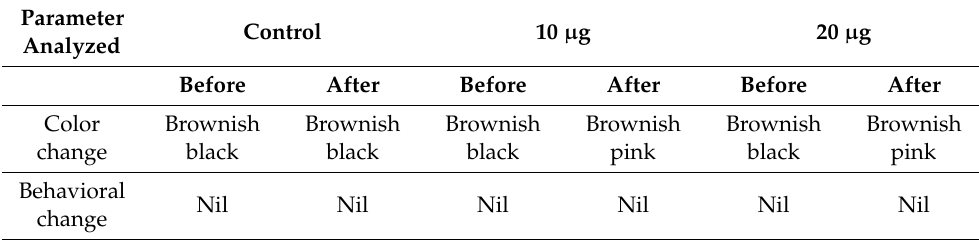
Figure 8. Phenotypic changes observed in zebrafish exposed to silver nanoparticles. ( a ) control; ( b ) exposed to 10 µg; ( c ) exposed to 20 µg.